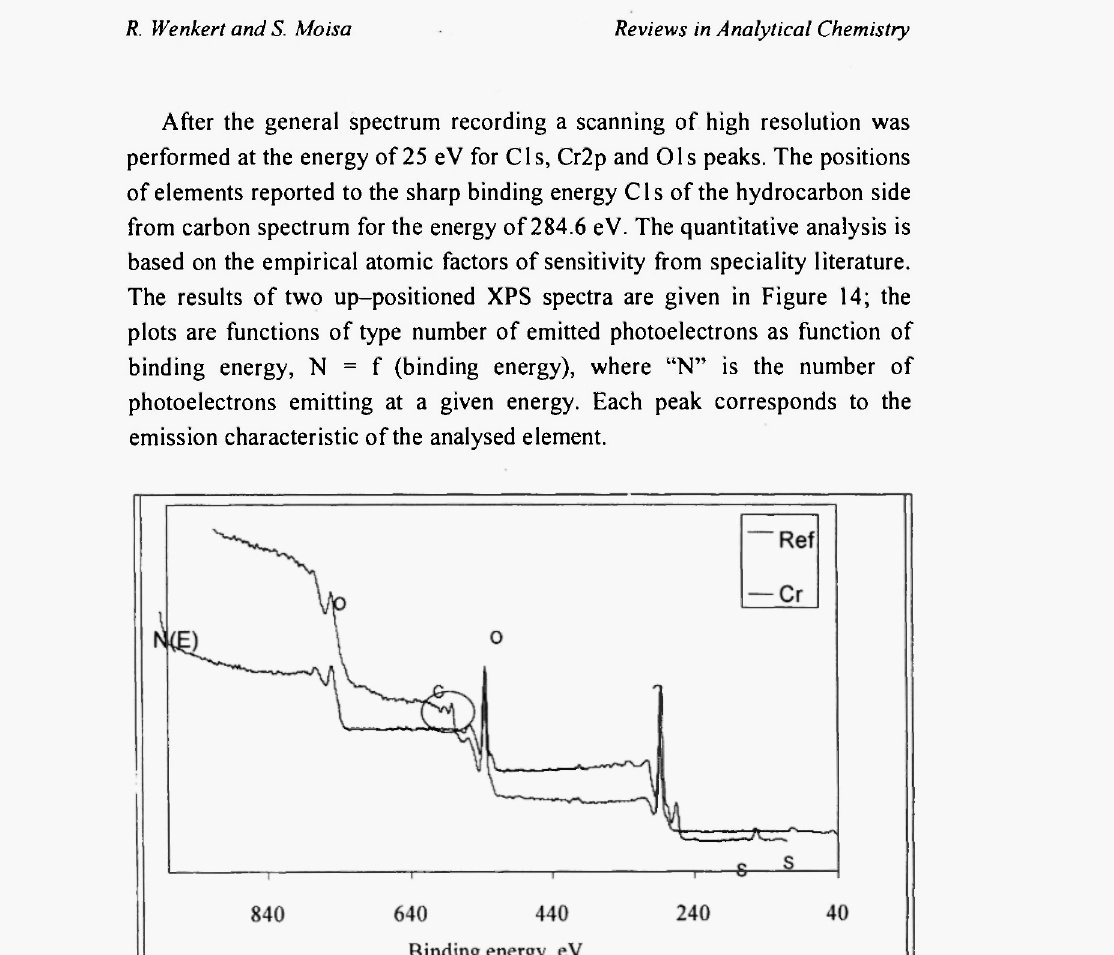
Fig. 10: The XPS general spectra obtained on the surface of analysed